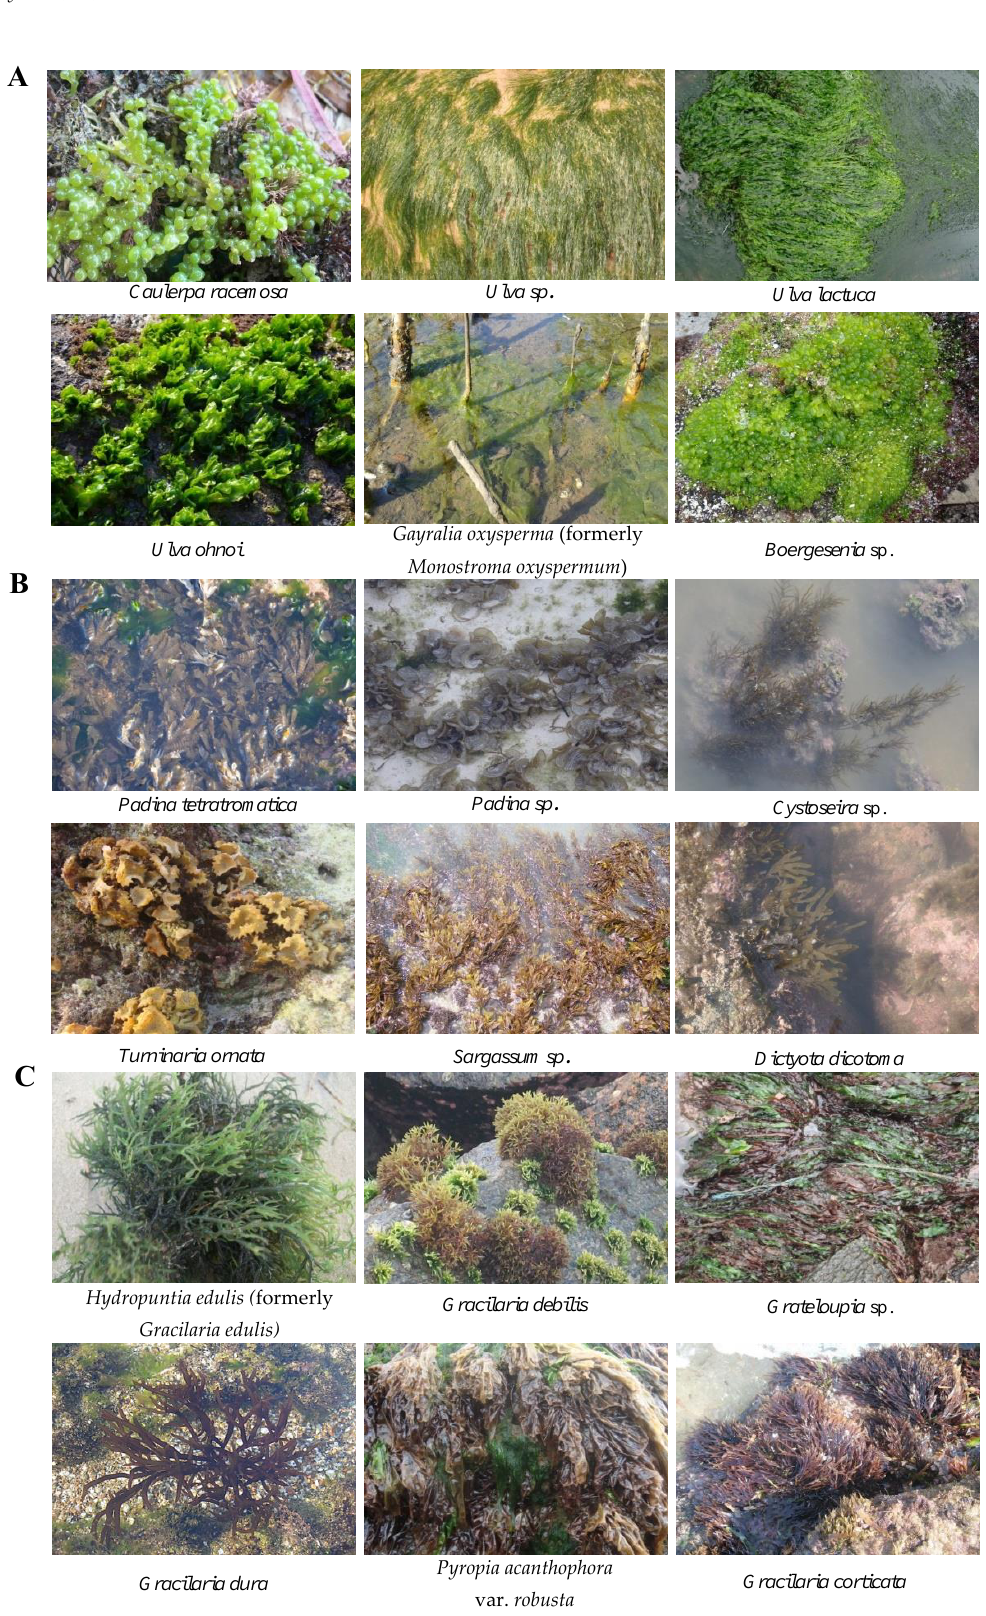
Figure 1. Common seaweeds of Indian coast, ( A ) Chlorophyta, ( B ) Ochrophyta, ( C ) Rhodophyta [Photo credit, Dr. Monica G. Kavale].